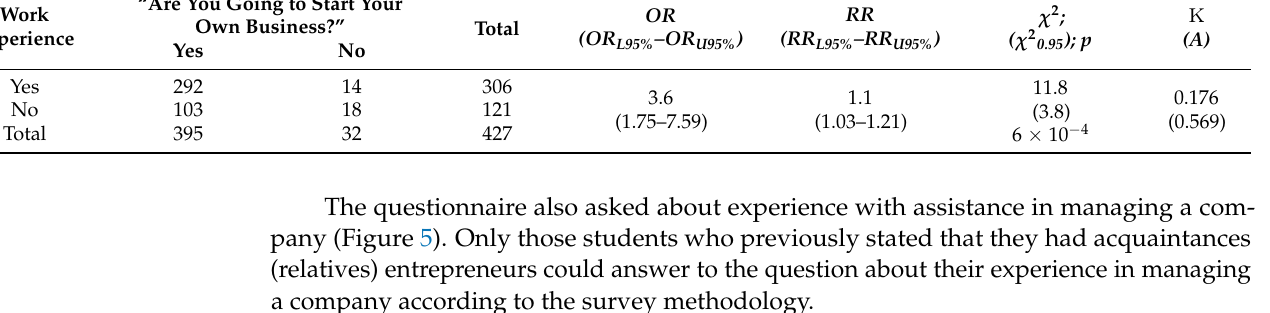
Table 3. Distribution of respondents ’answers regarding the hypothesis that practical experience has a positive effect on students’ intentions to start their own business. Work